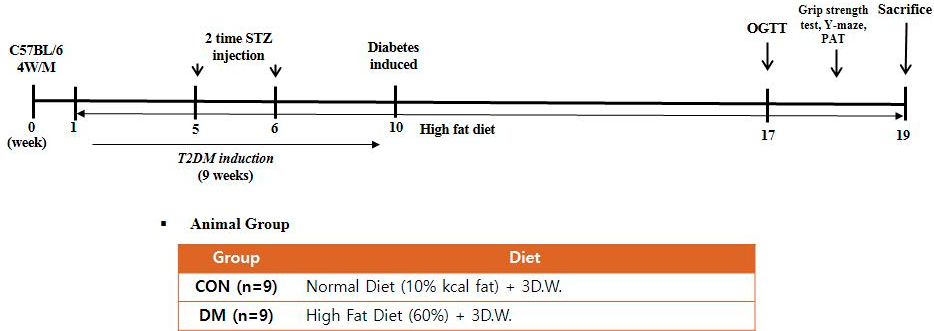
Figure 1 . Experimental design . Figure 1. Experimental